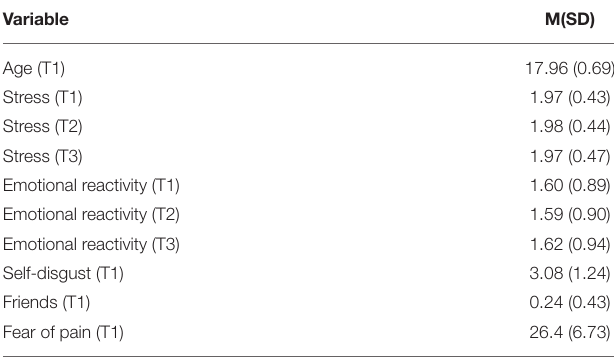
TABLE 1 | Means and standard deviations of study